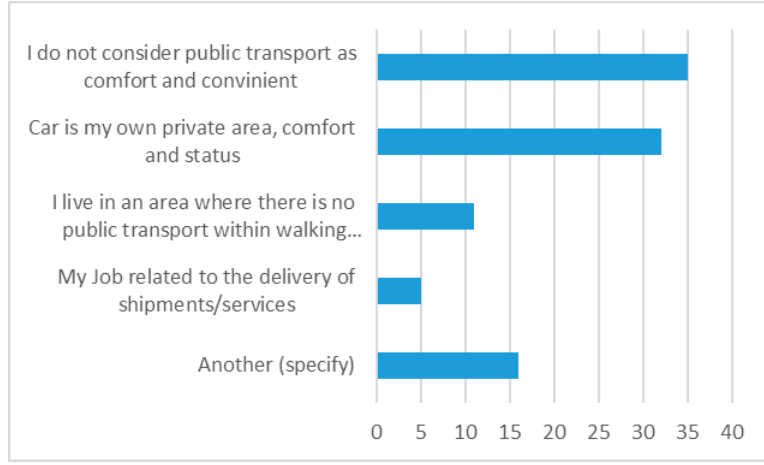
Figure 6. Reasons for increased use of personal cars.